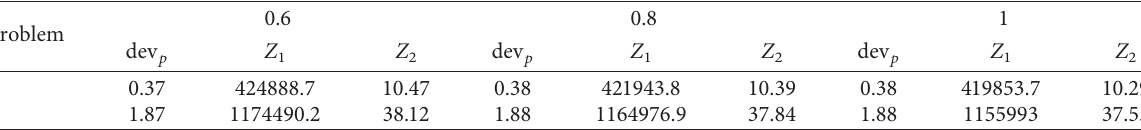
Table 13: The best Pareto solutions.